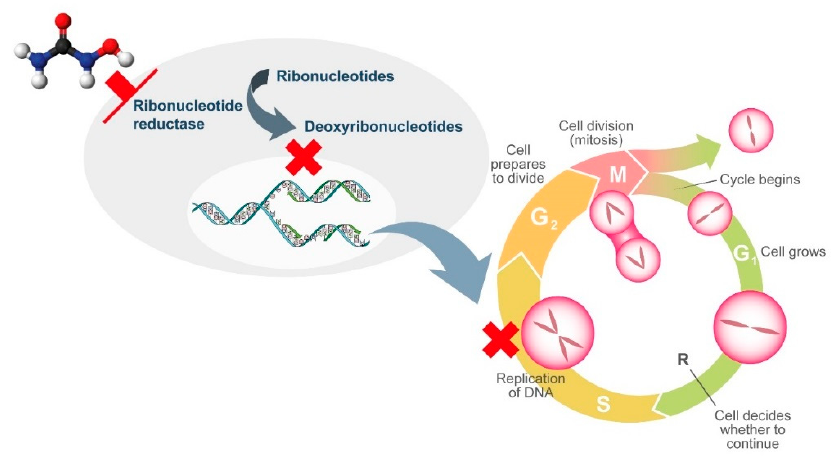
Figure 1. Mechanism of action of hydroxyurea. Ulcers are the most frequent reported cutaneous adverse event in patients with MPNs undergoing treatment with HU (Table